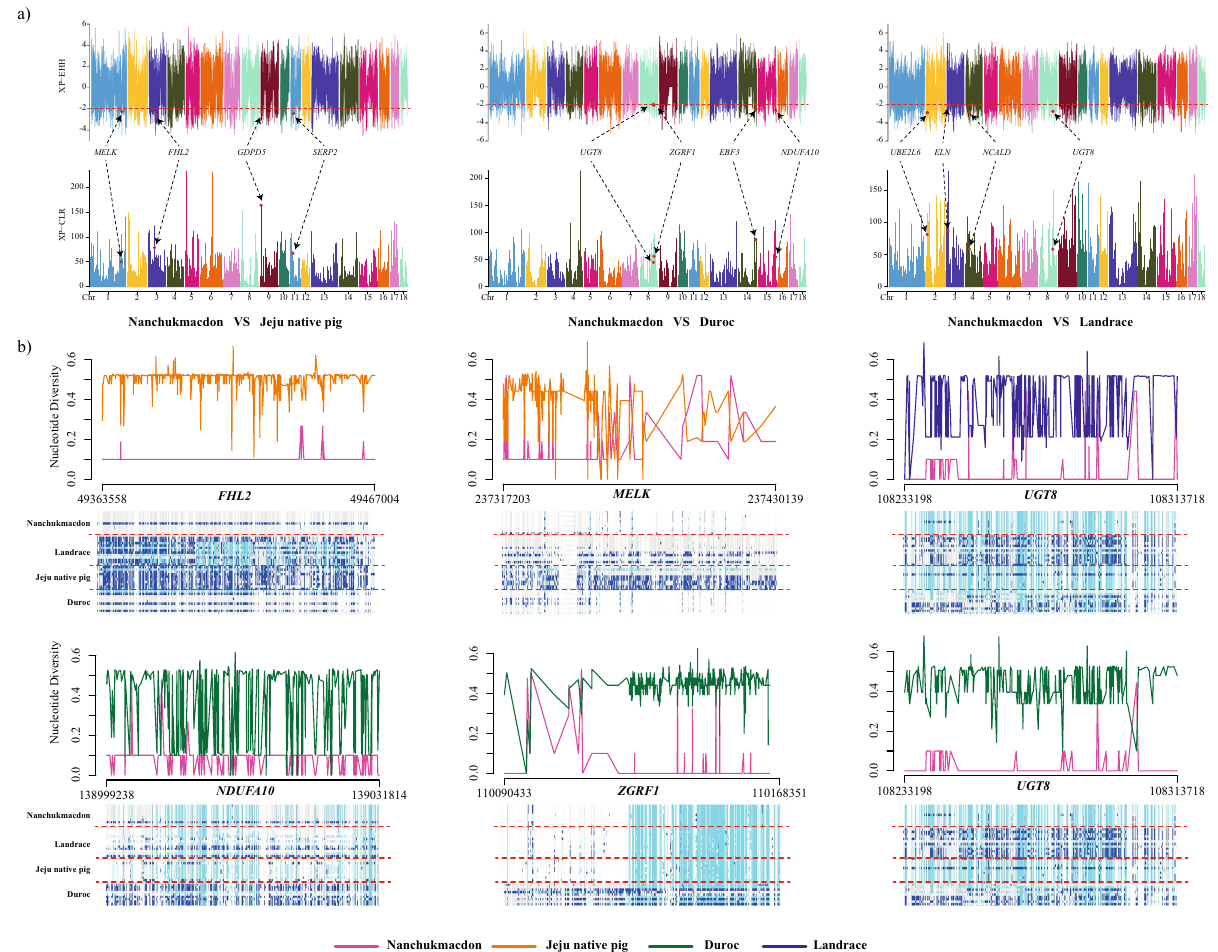
Figure 3. ( a ) Candidate selective sweep analysis for NC. A window size of 10k with the binning size of 10 was chosen and top 1% XP-CLR scores were extracted and a cutoff of -2 with significant p-value ≤ 0.05 were selected for XP-EHH scores. Commonly identified genes were subsequently mapped with differentially expressed genes. Positively expressed DEGs were indicated in red color. Nuclear diversity plot for the identified candidate genes ( b ) represent the nuclear diversity at each point of location and their respective haplotype distribution with genomic position biallelic alleles are shown in sky-blue (homozygous variant) and blue (Heterozygous